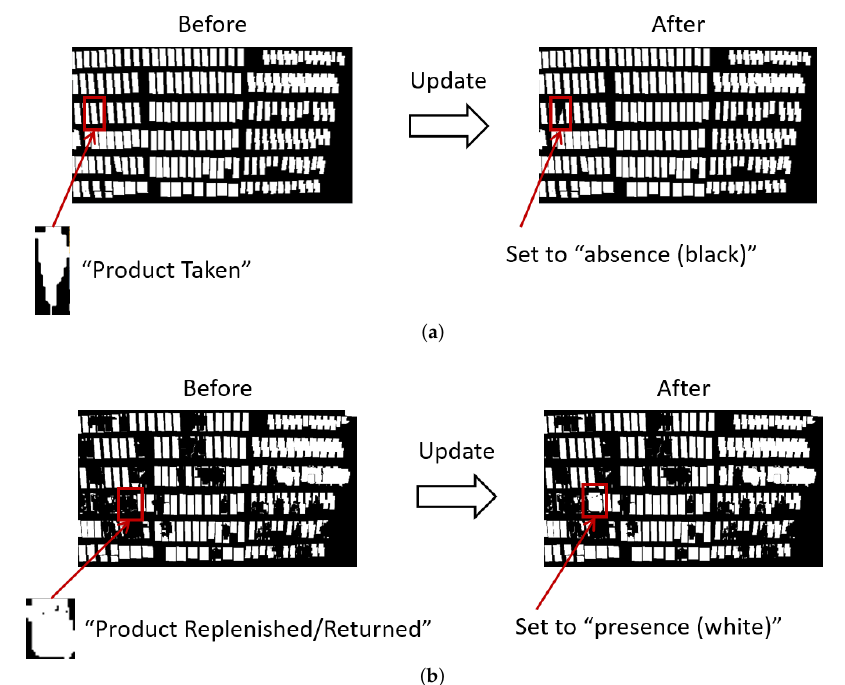
Figure 8. Examples of shelf condition represented as binary image. ( a ) “Product taken”. ( b ) “Product replenished/returned”.